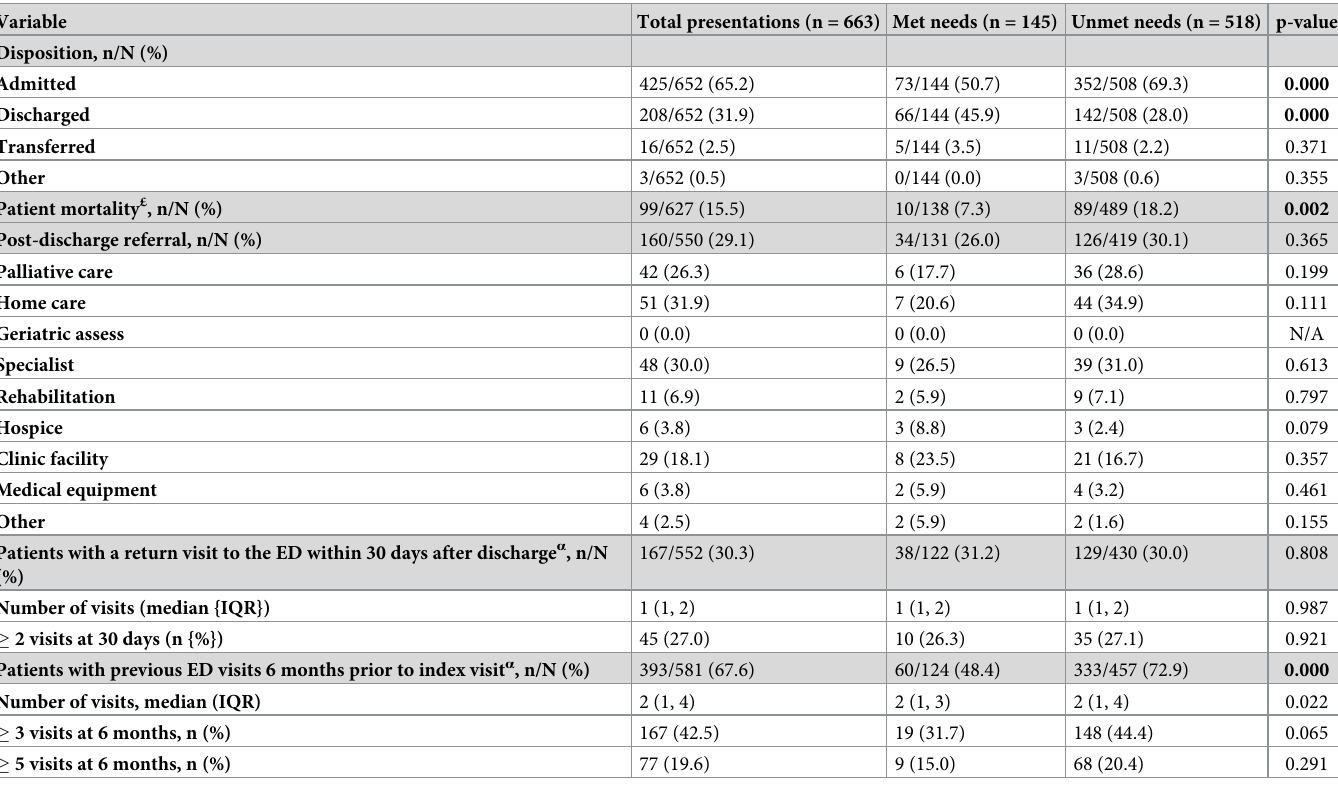
Table 4. Disposition and post-discharge referrals of 663 emergency department presentations by patients with end-of-life conditions compared on unmet vs. met palliative care needs.